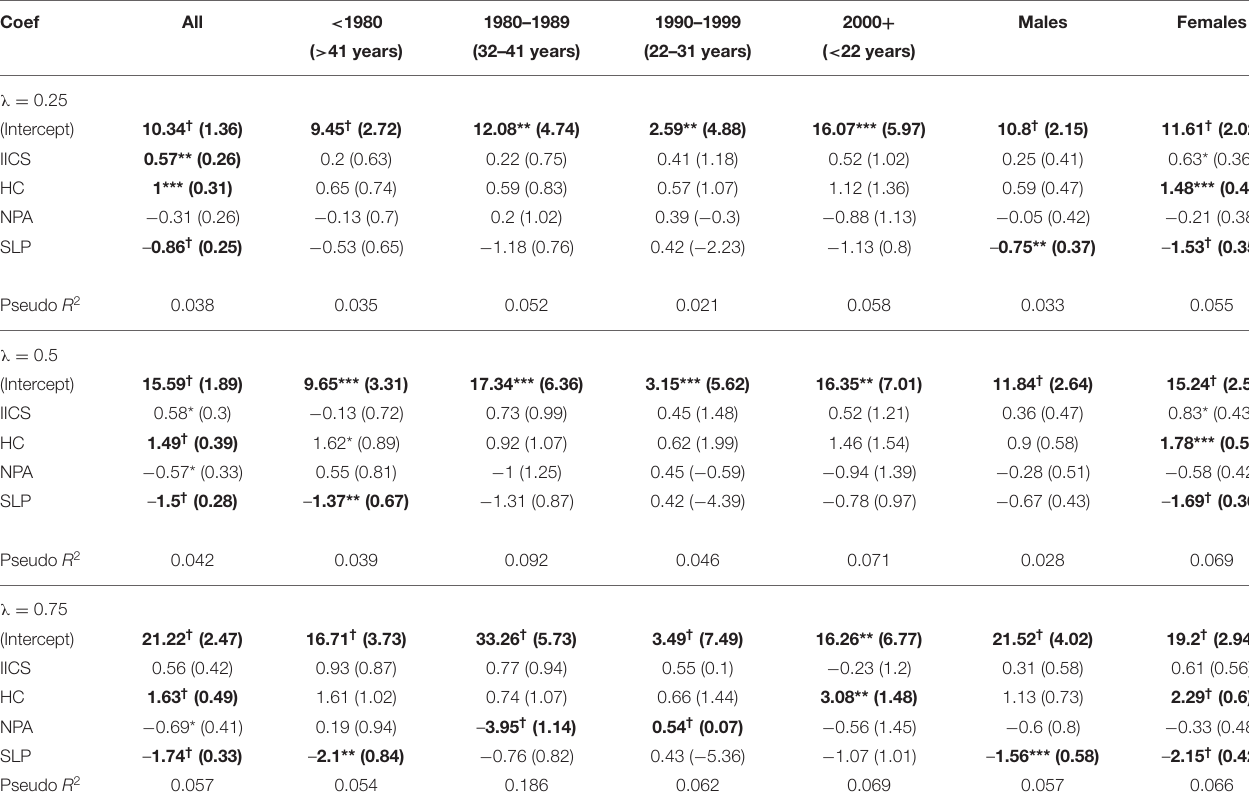
TABLE 2 | Quantile regression analysis—associations between self-care activities and depression for all participants and their categories by age and gender. Coef